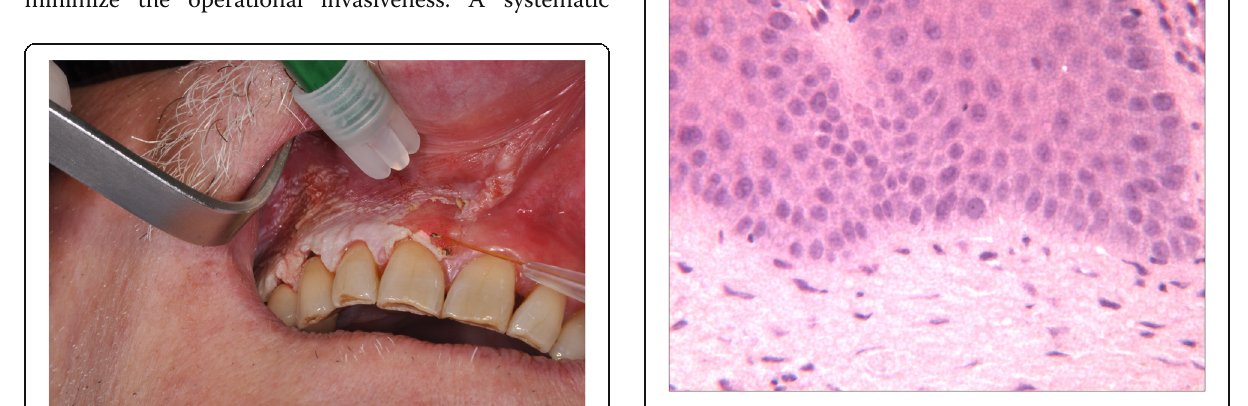
Fig. 6 Sample of tissue taken in the same area as the previous laser treatment: proliferative verrucous leukoplakia, basal layer without evidence of mitosis and cytological atypia (H&E, 400